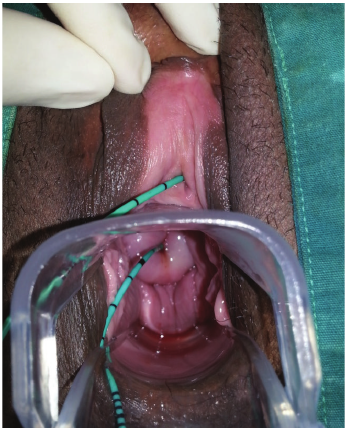
Figure 4: Exit of catheter stent through cystoscope to the fistula focus in bladder from cervical external